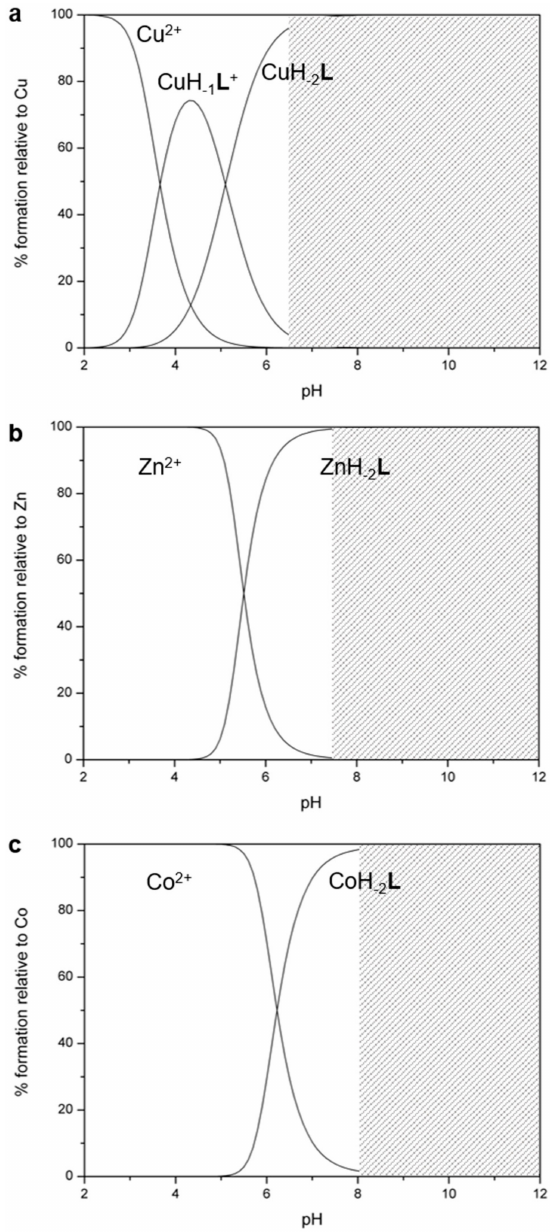
Figure 5. Distribution diagram of the species for the ( a ) L -Cu(II), ( b ) L -Zn(II) and ( c ) L -Co(II) ( L = L1 ) system in 1:1 molar ratio as a function of pH in an aqueous solution (I = 0.15 mol dm − 3 NaCl, T = 298.1 K, [ L ] = [Cu(II)] / [Zn(II)] / [Co(II)] = 1 × 10 − 3 mol dm − 3 ). The scarce solubility of the neutral species of L1 with all metal cations precluded the investigation beyond pH 6.3, 7.3 and 8.0 for Cu(II), Zn(II) and Co(II), respectively, under these experimental conditions. Accordingly, dark areas have been inserted in the